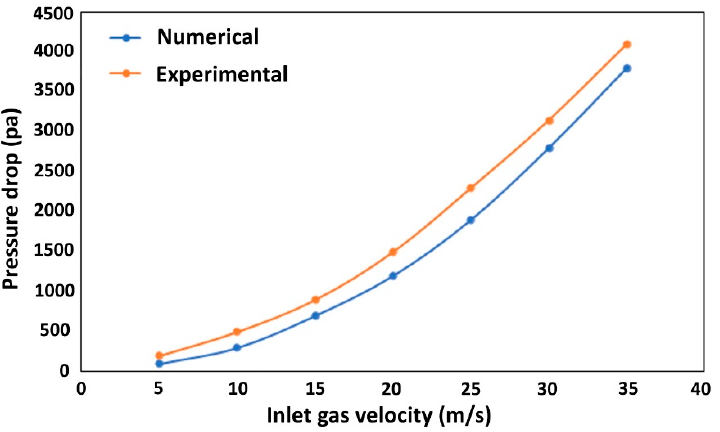
Figure 8. The influence of the inlet velocities on the pressure drop in the cyclone [20].